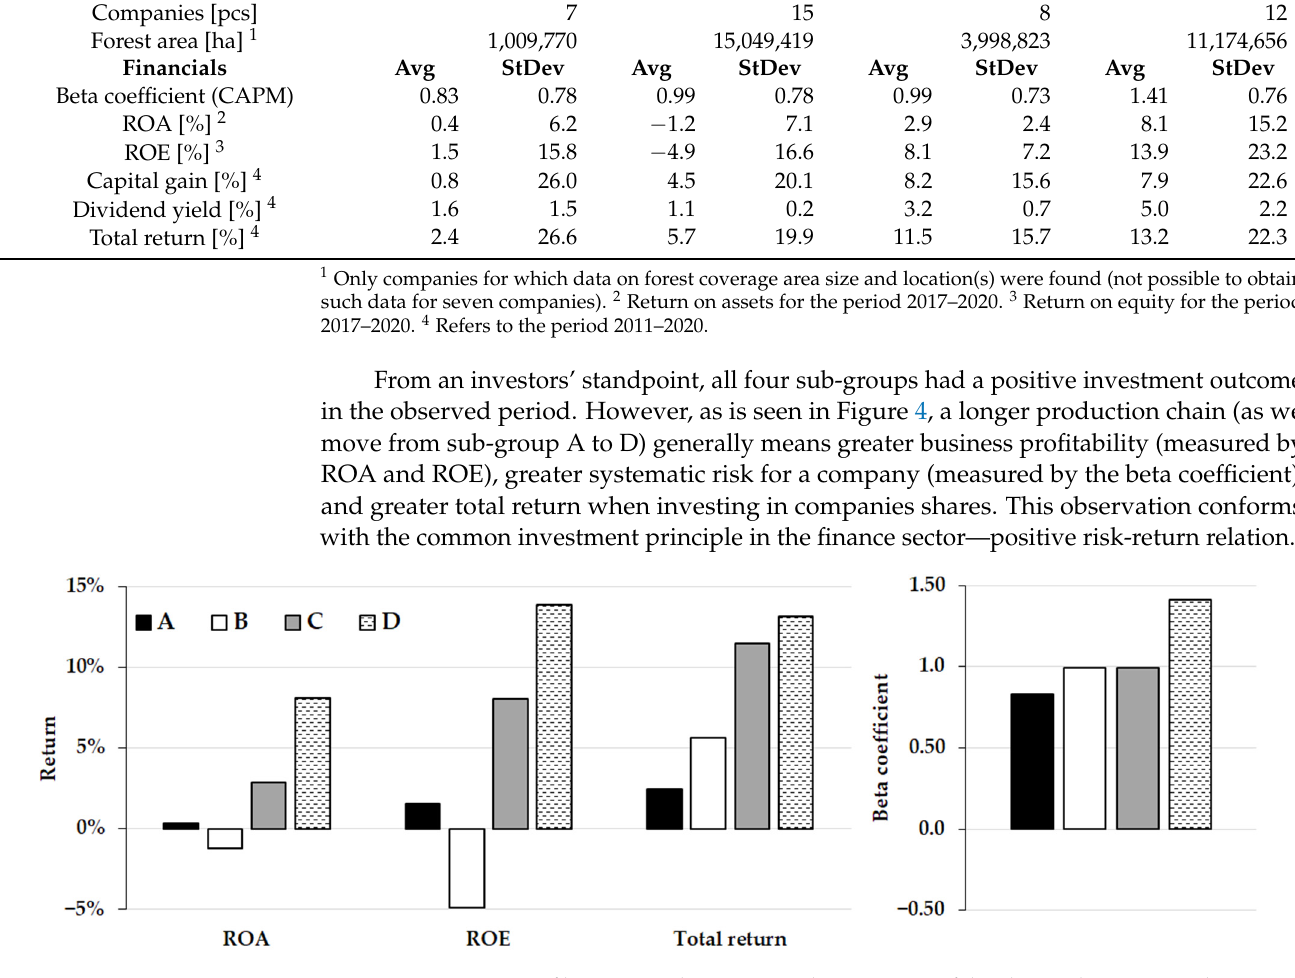
Figure 4. Comparison of business and investment characteristics of the observed company sub- groups.